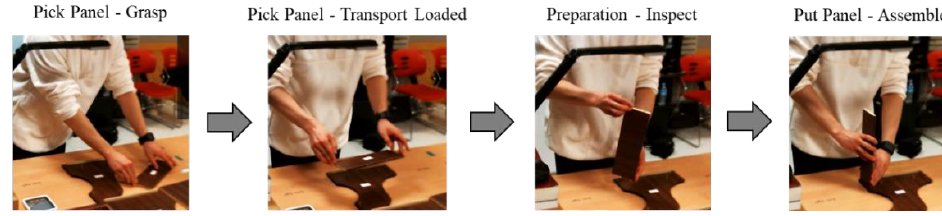
Figure 14. The example of activities to assemble the main panel.